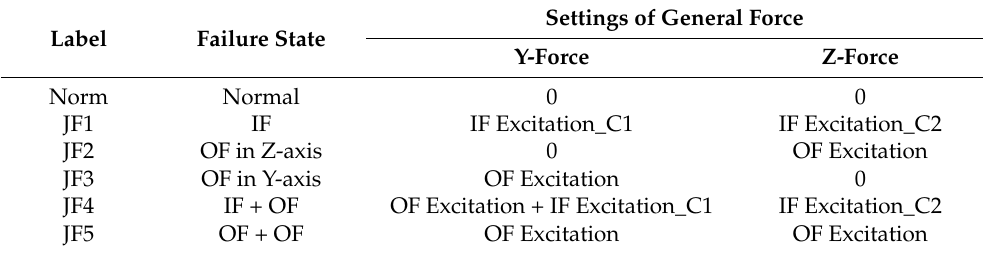
Table 6. The overview of joint fault types.